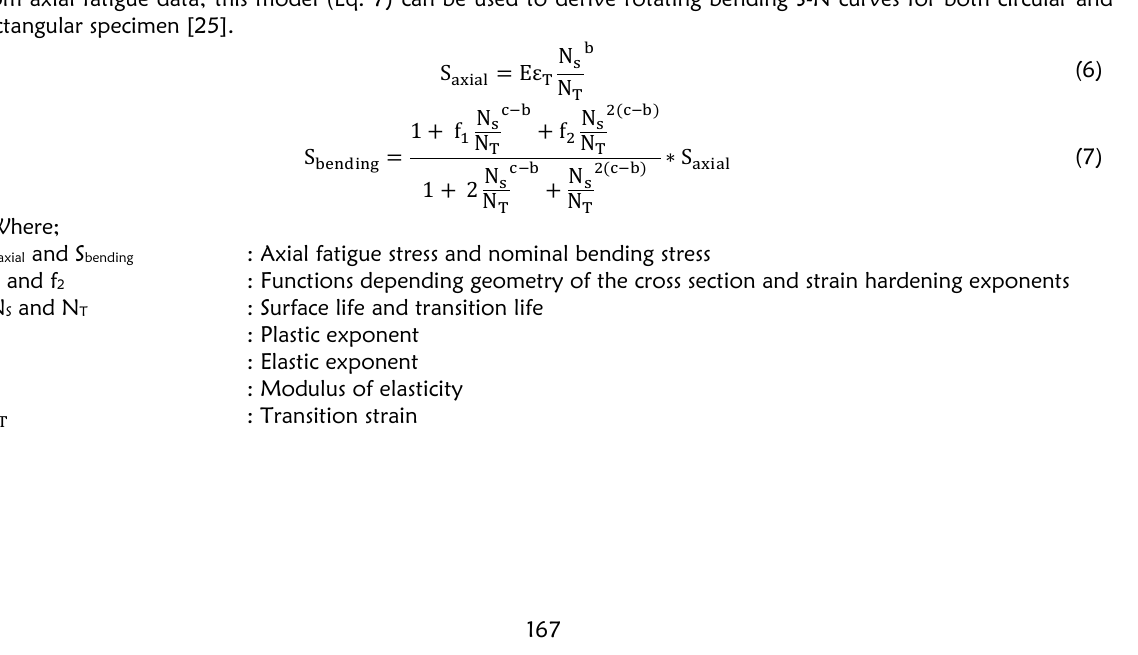
Philipp [24] first observed that fatigue life after rotate bending was longer than that from axial loading. The authors proposed the ratio between axial stress and bending stress ( 𝜎 𝑎𝑥𝑖𝑎𝑙 /𝜎 𝑏𝑒𝑛𝑑𝑖𝑛𝑔 ) to be 0.59 as the correction factor. Another model was also proposed [23] based on study of microplasticity, however this model was not accurate due to conflicting experimental and theoretical results. The different results were also reported when testing at different modes and shown in Figure 13. The presence of a stress gradient in bending fatigue, cyclic strain hardening and softening, difference in crack propagation effects and difference in nominal stress in bending differed considerably from true valued due to plastic flow. The authors proposed a model to determine the S-N curve for bending fatigue from axial fatigue data; this model (Eq. 7) can be used to derive rotating bending S-N curves for both circular and rectangular specimen